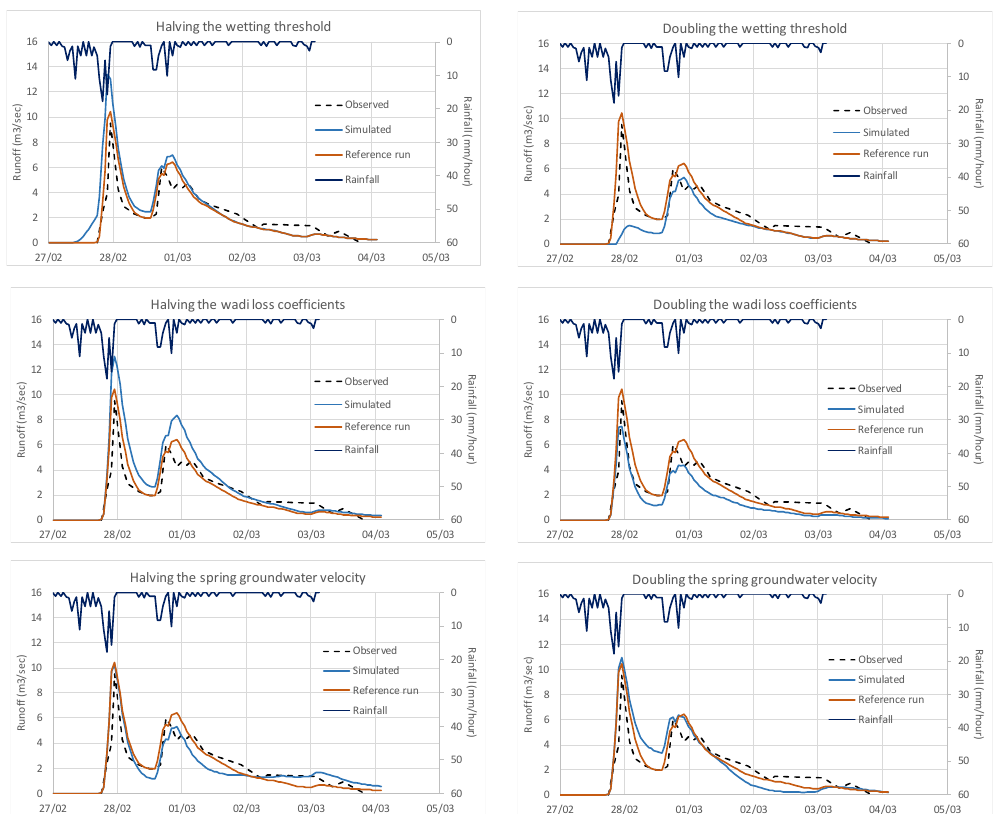
Figure 8. Sensitivity analysis for the three main hydraulic parameters: wetting threshold, wadi loss coefficients, and spring groundwater velocity. Time series were recorded at the Ein Ayoub (Ayb) gauging station. Dates on X axis are formatted in day/month (dd/mm) for 2009.